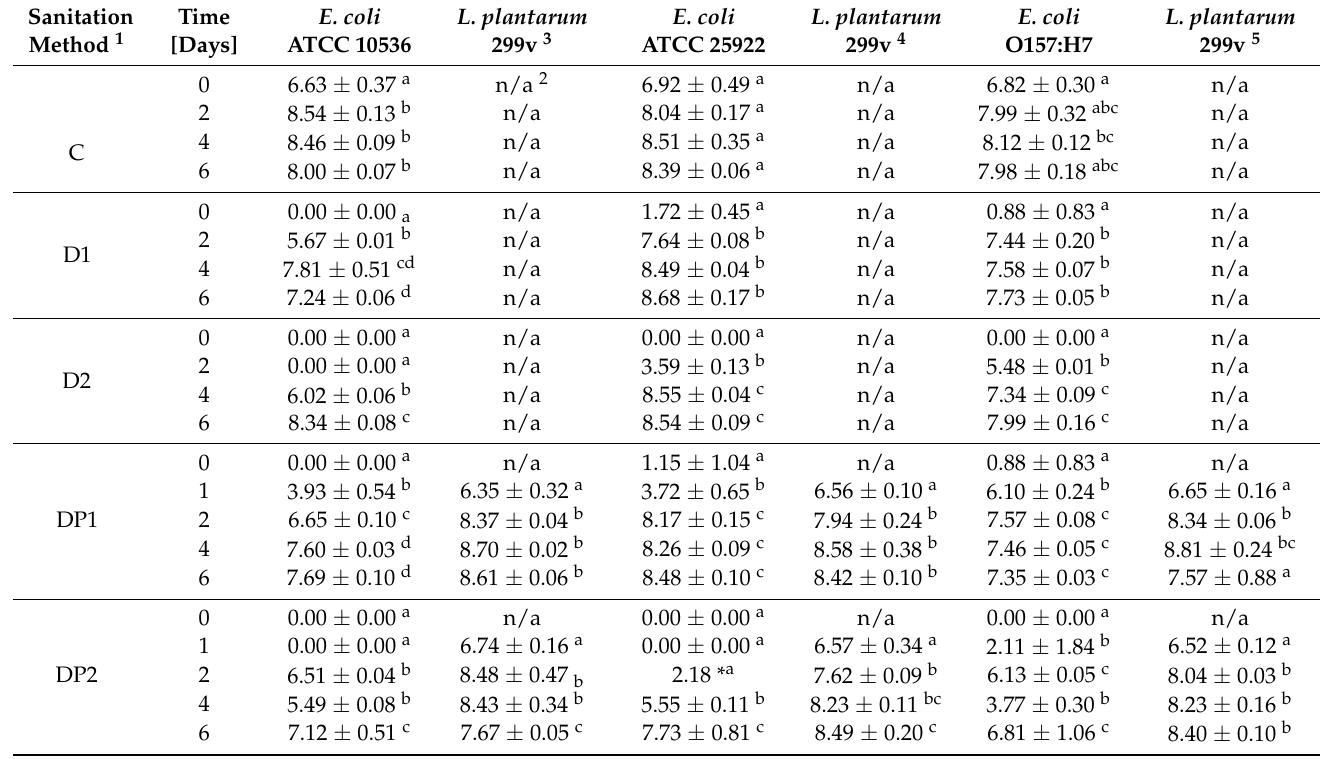
Table 1. The average number of Escherichia coli and Lactobacillus plantarum 299v on mung beans seeds sanitised by different methods and sprouted [log CFU g − 1